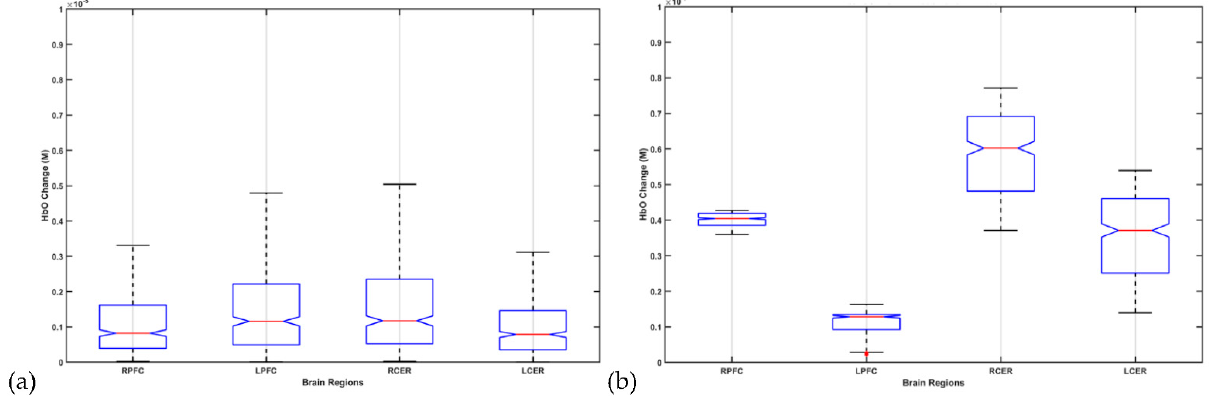
Figure 11. Box-plot of post-intervention HbO change from the pre-intervention baseline due to 2 mA ctDCS in ( a ) and ±2 mA (max) phase–amplitude-coupled ctACS in ( b